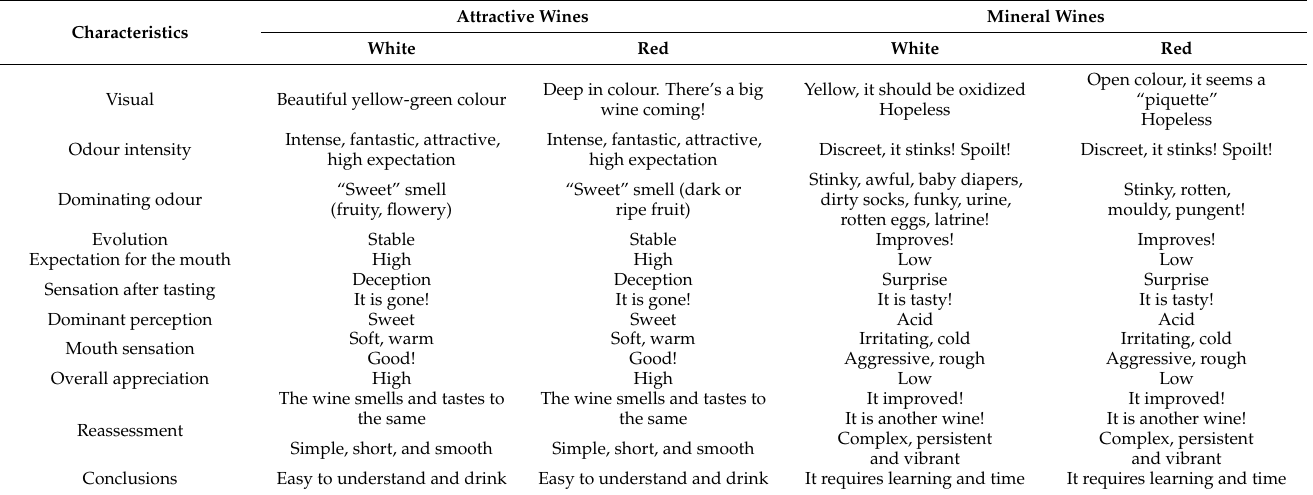
Table 2. Examples of informal responses given by untrained consumers when tasting fruity attractive wines in comparison to mineral wines during educational